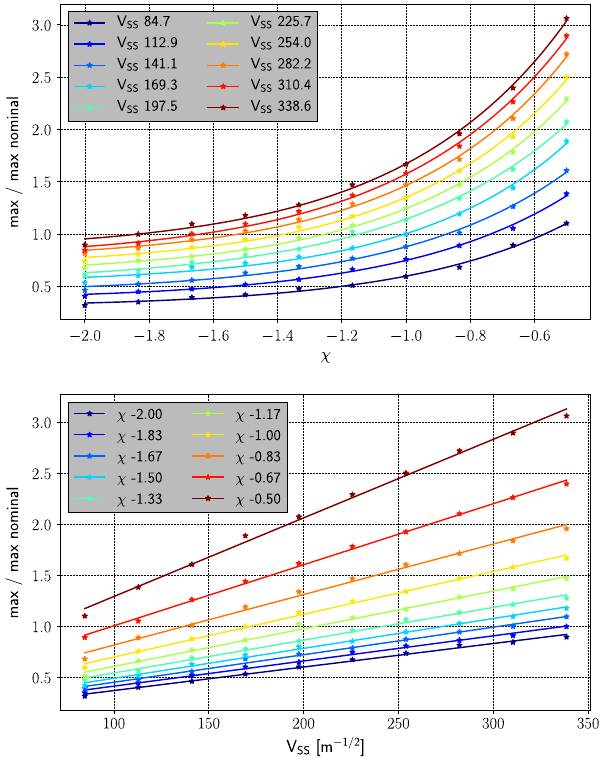
FIG. 18. 1D projections of the transfer function maximum, normalized to the one of the nominal SPS working point. Top: fixed V curves as a function of χ . Bottom: fixed χ curves as a ss function of V . ss